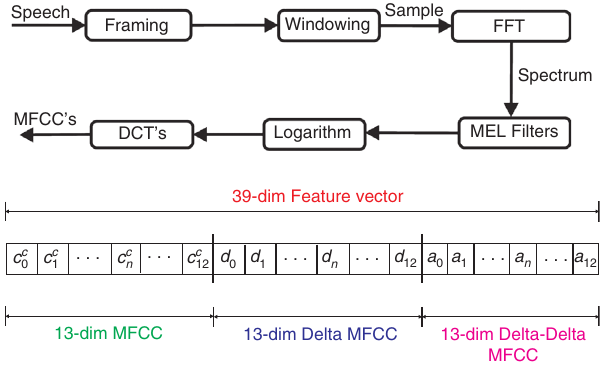
Figure 5. MFCC Feature Extraction